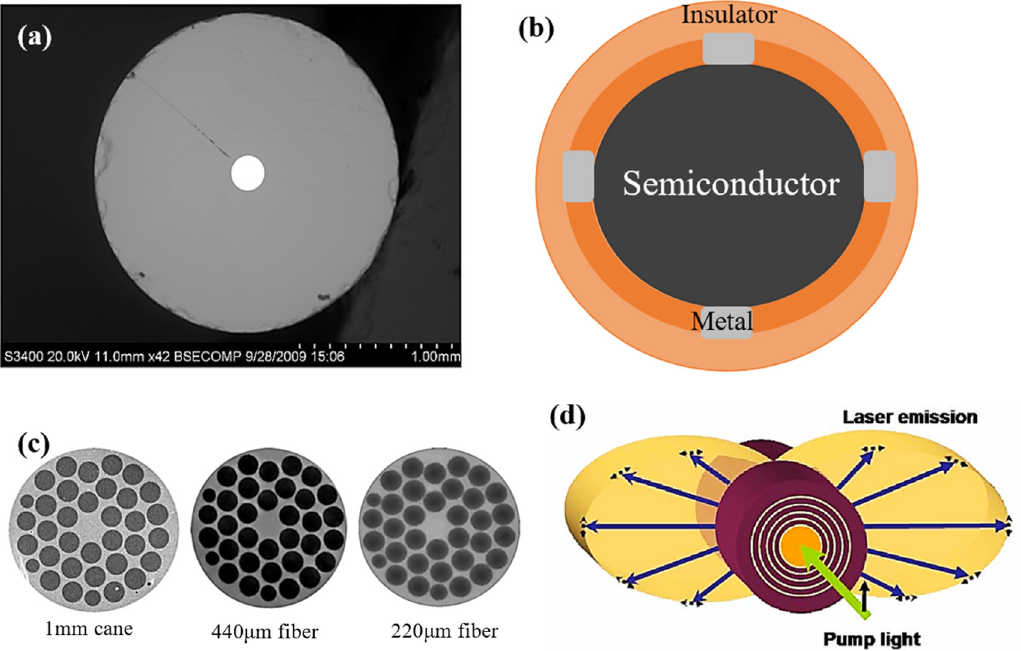
Figure 5. Semiconductor optical fibers of different geometries: ( a ) semiconductor core fiber (Reprinted with permission from ref. [119]. Copyright 2010 Optical Society of America), ( b ) metal-semiconductor-insulator fiber, ( c ) MOFs (Reprinted with permission from ref. [120]. Copyright 2003 Optical Society of America), and ( d ) PBG fiber (Reprinted with permission from ref. [121]. Copyright 2006 Optical Society of America).